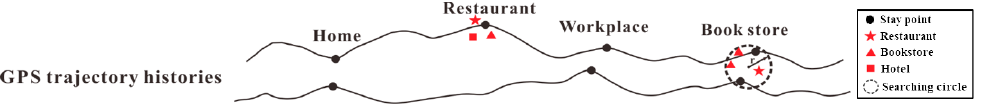
Figure 3. An example of extracting the semantics of public places of interest.